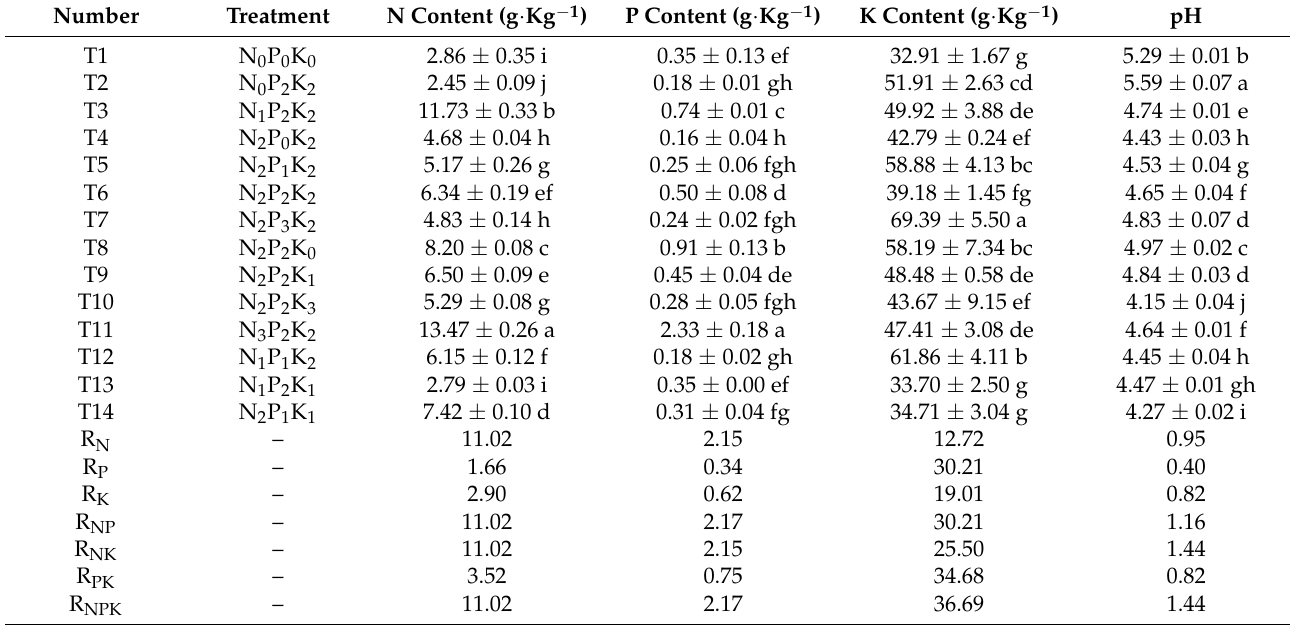
Means ± SD with different letters indicate a significant difference among the 14 treatments, as determined by Duncan’s multiple range test ( p < 0.05). R means the difference between the maximum and minimum values at different levels for single-factor, two-factor, and three-factor effects of N, P, and K fertilizer. R N is the difference at 4 N levels (T2, T3, T6, and T11), R P at 4 P levels (T4, T5, T6, and T7), R K at 4 K levels (T8, T9, T6, and T10), R NP at 8 NP levels (T2, T3, T4, T5, T6, T7, T11, and T12), R NK at 8 NK levels (T2, T3, T6, T8, T9, T10, T11, and T13), R PK at 8 PK levels (T4, T5, T6, T7, T8, T9, T10, and T14), and R NPK at 14 NPK levels